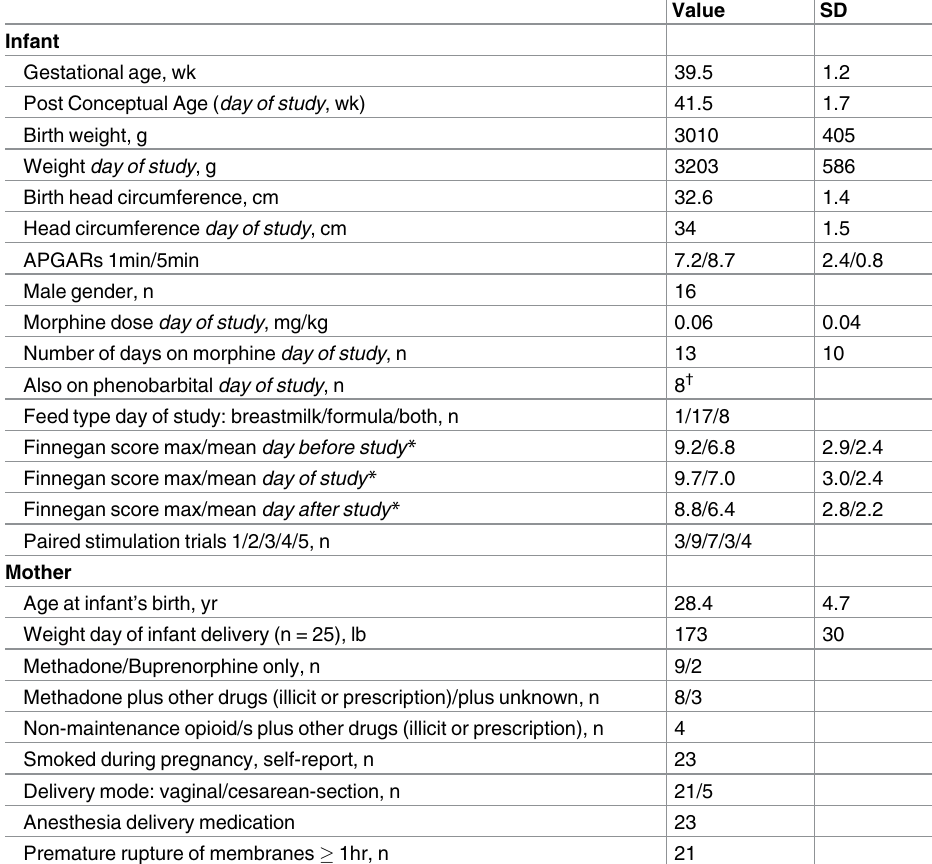
Table 1. Characteristics of the study